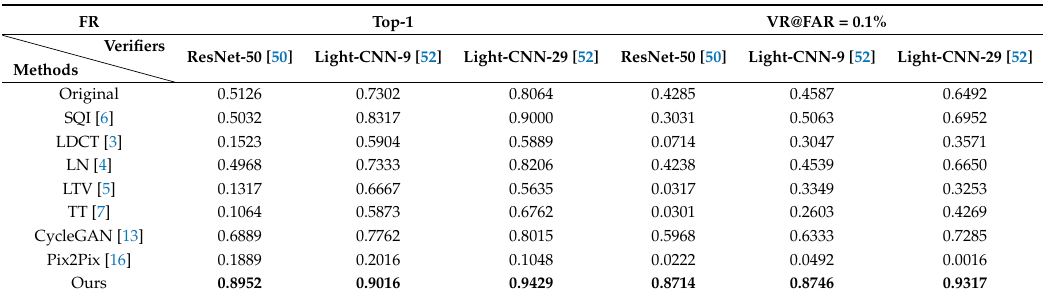
Table 4. Top-1 identification accuracy and verification accuracy at 0.1% FAR on the YaleB dataset using ResNet-50, Light-CNN-9 and